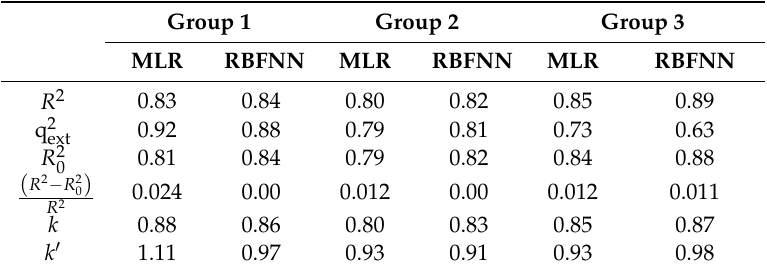
Table 5. The statistical results of the external test set for the three models of each group.